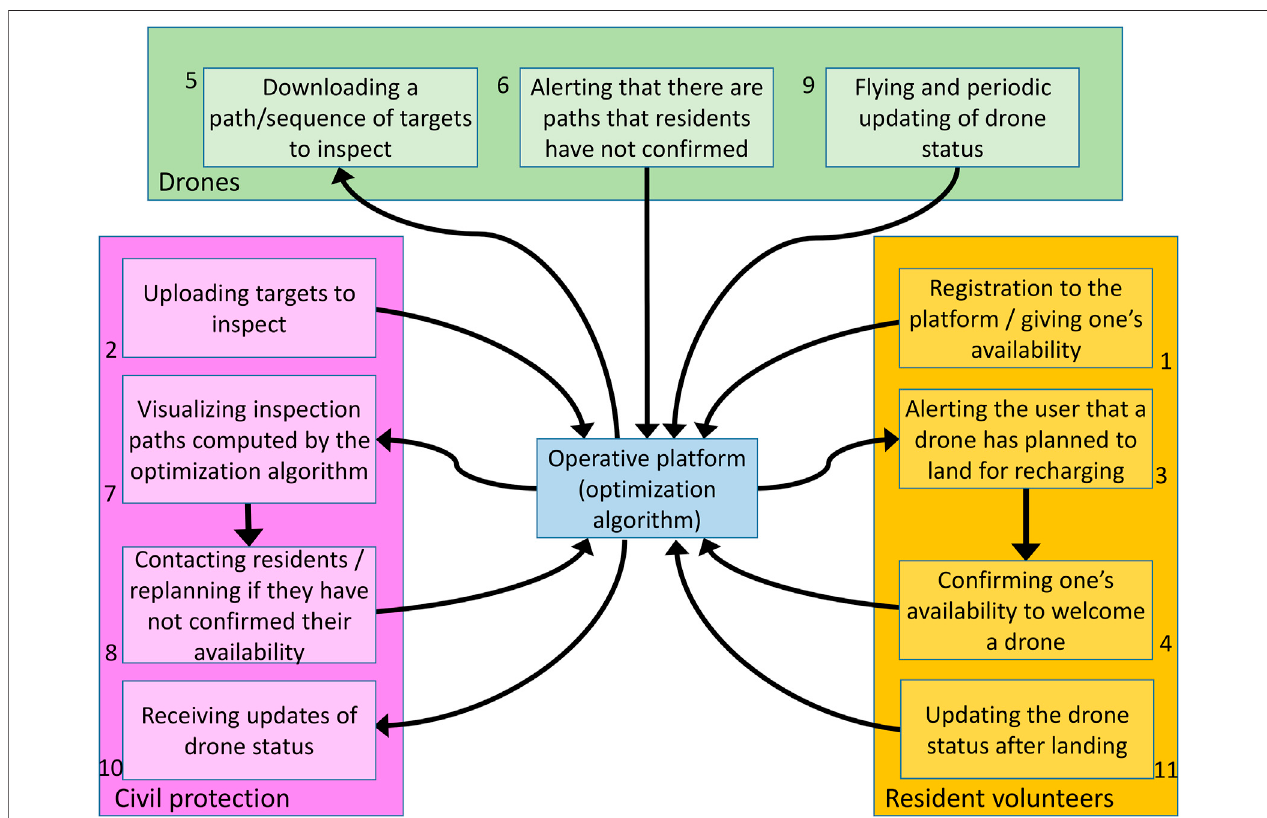
FIGURE 2 | Actors in the cloud. 1: resident volunteers registers to the platform; 2: the Civil protection uploads targets; 3, 4: residents con fi rm their availability to welcomeadrone;5,6:dronesperiodicallycheckifthereisamissionforthemandalertthesystemifanyresidentsalongthepathdidnotcon fi rmtheiravailability;7,8:the Civil protection checks if there are uncon fi rmed paths and possibly recompute them; 9: drones start the mission by periodically updating their status; 10: the Civil protection receives periodic updates about the mission status; 11: if a drone needs to be recharged, a citizen is alerted and updates the mission status after the drone has landed on their